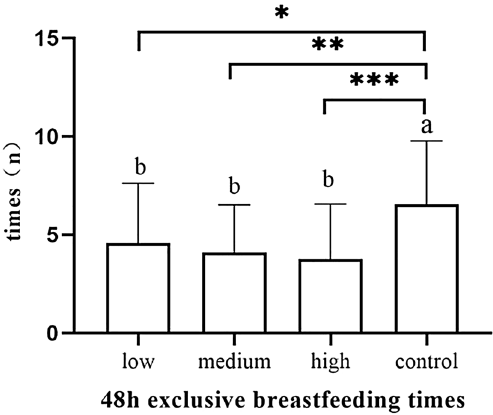
Figure 14. The number of exclusive breastfeeding sessions of 48